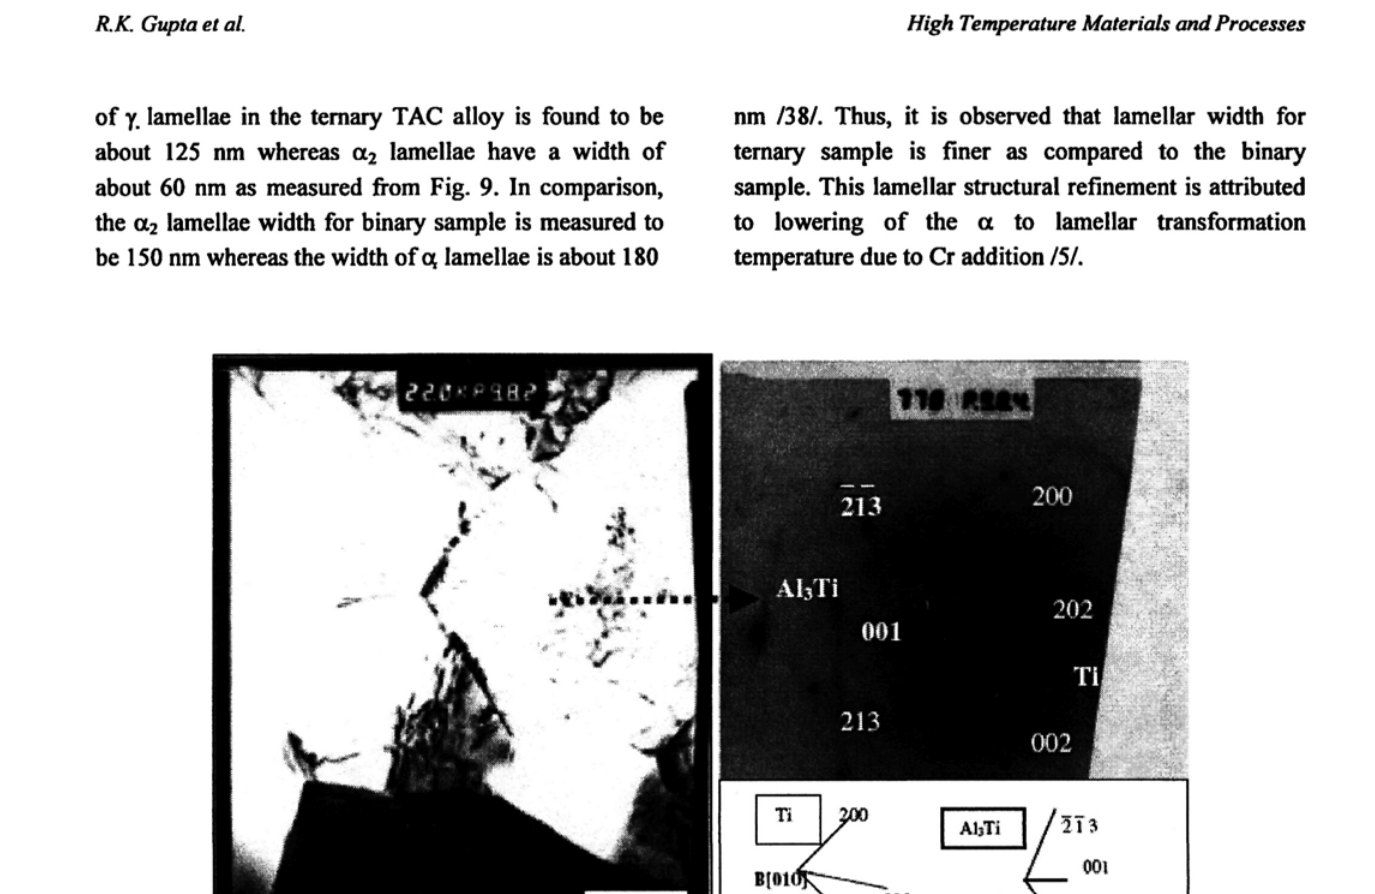
Fig. 7: TEM micrograph and SAD pattern of as-pressed TAC sample from a region showing Ti and Al